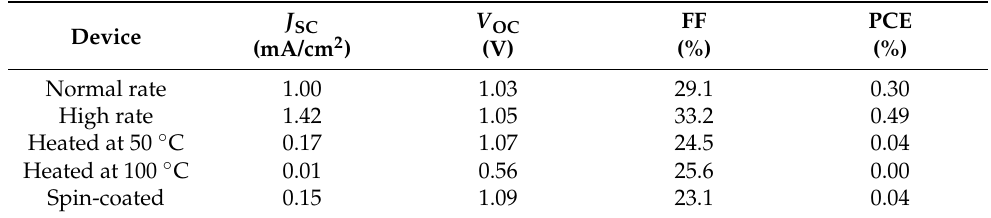
Figure 6. J - V curves of the DTDCPB single-component cells with various film preparation conditions under AM1.5G illumination. Table 3. Device performance parameters of the DTDCPB single-component cells with various film preparation